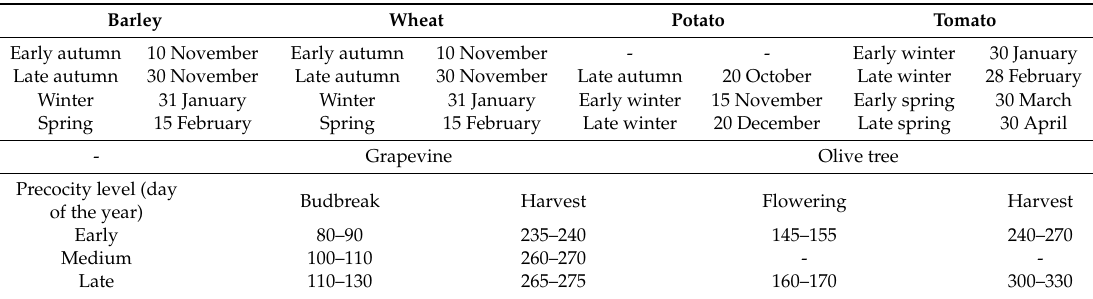
Table 3. Sowing dates tested for barley, wheat, potato, and tomato and precocity levels for grapevine and olive